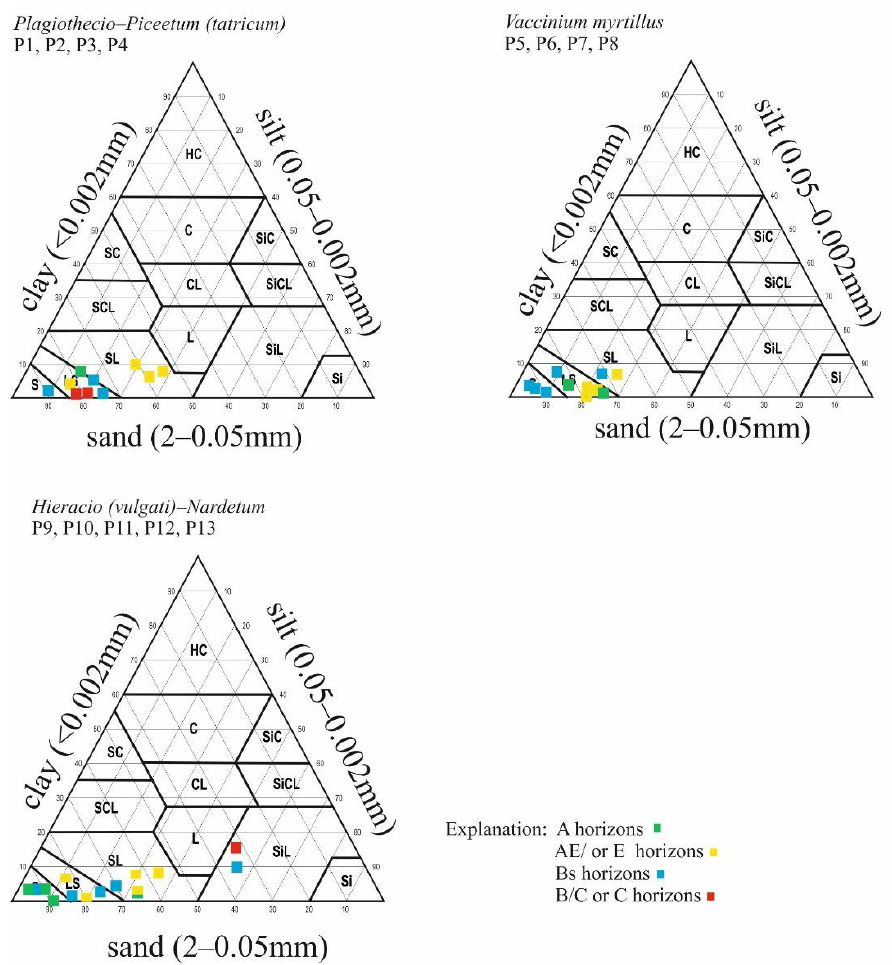
Figure 2. Particle sized distribution of studied soils under different vegetation.